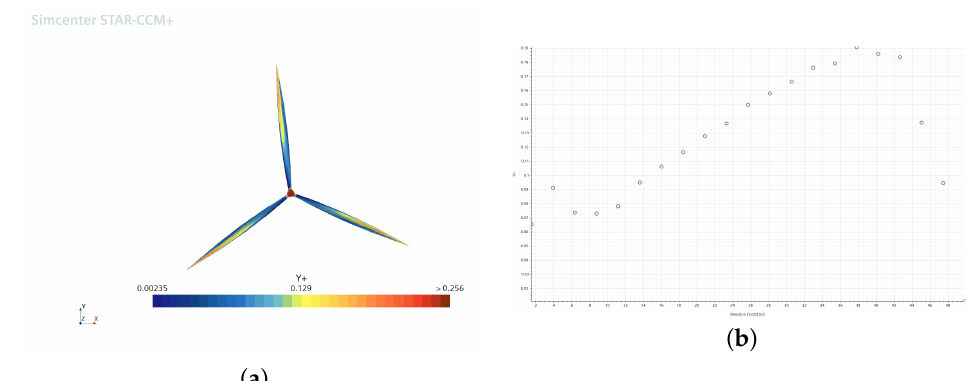
Figure 7. Distribution of the Y+ value on the wind turbine blades. ( a ) 3D model, ( b ) graph.